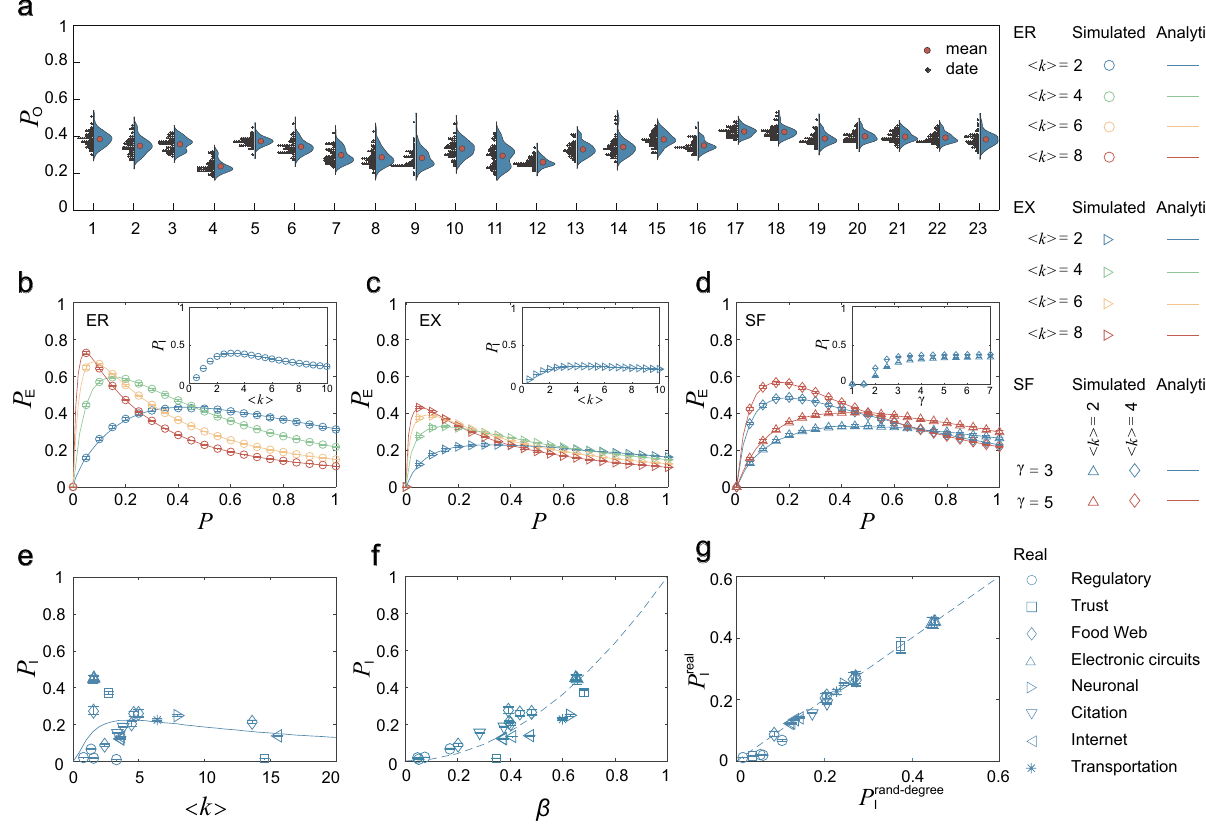
Figure 3. The role of coupling. ( a ) The half violin plot of P O for real networks. The proportion P E of effective coupling and its trapezoidal numerical integration P I in ( b ) ER networks, ( c ) EX networks, and ( d ) SF networks as the function of the coupling density P , the average degree (cid:31) k (cid:30) and the power exponent γ , respectively. ( e ) The integration P I of real networks as the function of (cid:31) k (cid:30) . ( f ) The integration P I of real networks as the function of rand − degree the correlation parameter β . ( g ) The integration P I obtained from the degree-preserving randomized version of the real networks, compared with P real I